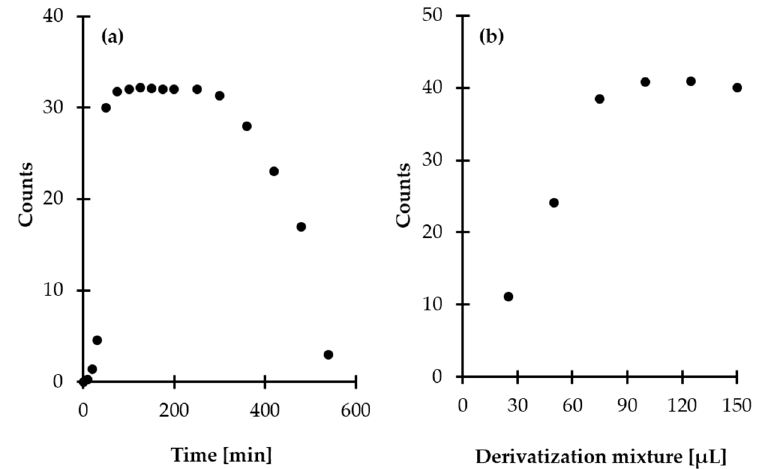
Figure 5. Derivatization reaction yield as a function of ( a ) reagent excess and ( b ) time combined with examination of HPPTCA-TMS stability in autosampler, expressed as a peak area of HPPTCA-TMS derivative. Samples were analyzed according to the procedure described in Section 3.7.